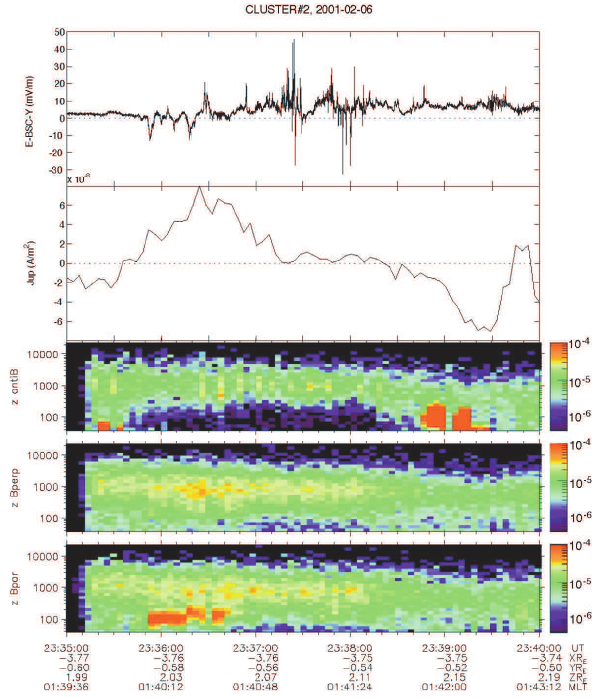
Fig. 23. Cluster 2 measurements above an auroral arc. From top to bottom: high-resolution electric field from the EFW, FAC (positive values correspond to current away from the ionosphere) from the FGM, and electron fluxes in the anti-parallel (upward), perpendicu- lar and parallel (downward) to B directions from the PEACE HEEA instrument in units of erg cm − 2 str − 1 s − 1 eV − 1 . (From Aikio et al.,